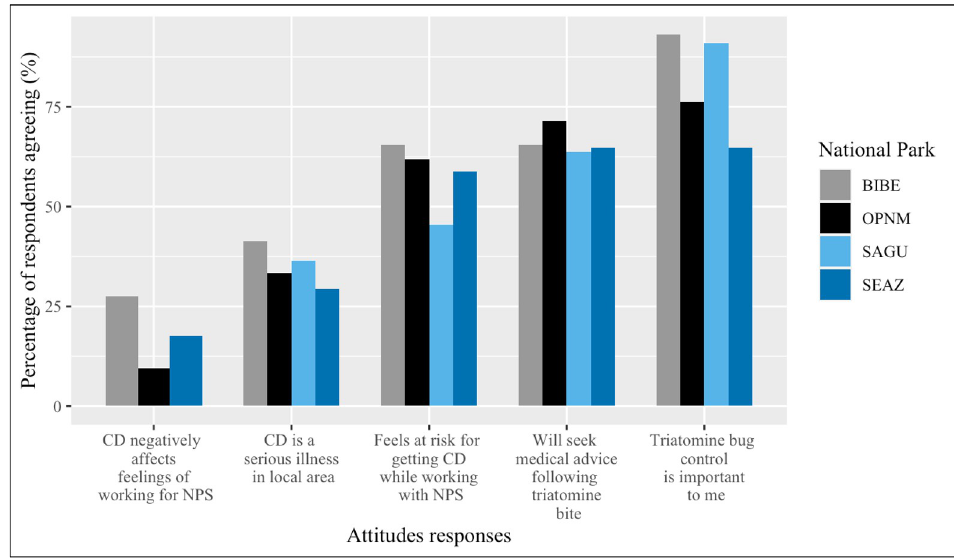
Fig 2. Proportion of respondents agreeing with attitudes statements by national park. Asterisk ( � ) indicates a significant difference between BIBE, OPNM, and SEAZ respondents (p < 0.05).